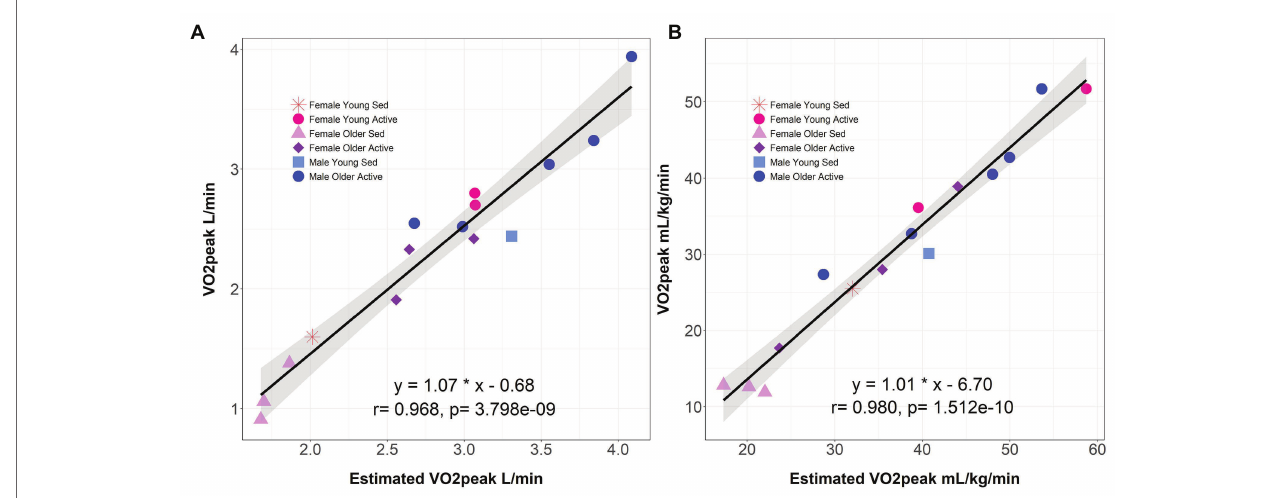
FIGURE 1 | Correlation between estimated and measured VO 2 max. The submaximal Ekblom-Bak method estimate of VO 2 max compared to the measured maximal VO 2 max L min −1 (A) and ml kg −1 min −1 (B) . Linear regression equation for interpretation of intercept and slope are presented, where measured VO 2 max is the dependent variable and estimated VO 2 max is the independent variable. Pearson correlation coefficient and p- value are reported for each association examined. Shading represents 95% CI. Individuals are coded by gender, age (Young = 25–28 years old; Older = 56–73 years old), and current physical activity level (Sedentary = 198–900 MET-minutes/week; Active = 4,236–25,992 MET-minutes/week). VO 2 max, maximal oxygen consumption; Sed, Sedentary.